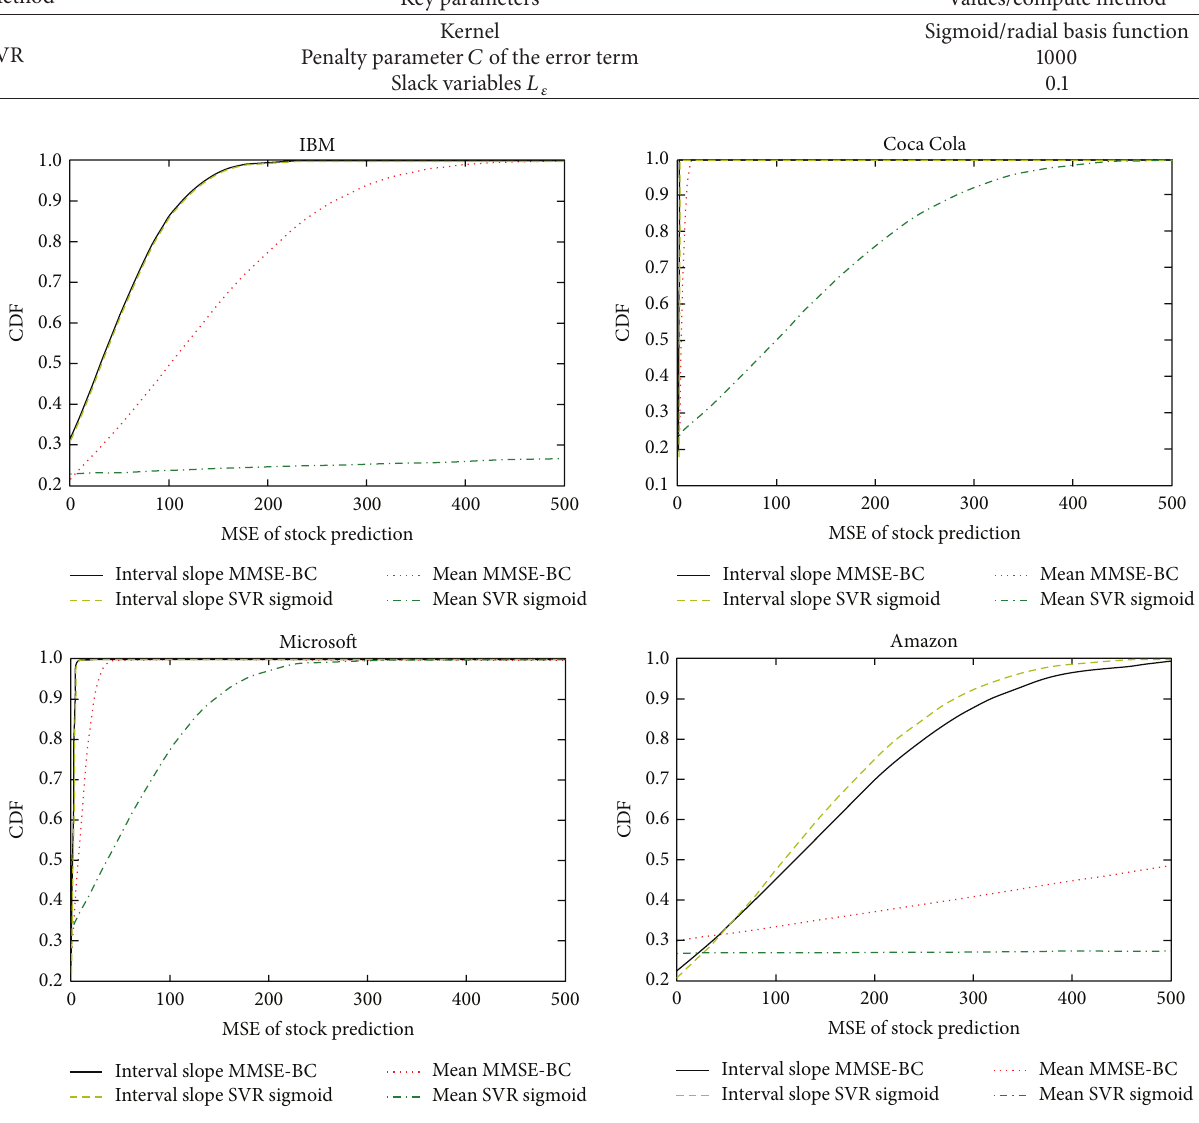
Figure 4: CDF of MSE for prediction of trends in stock